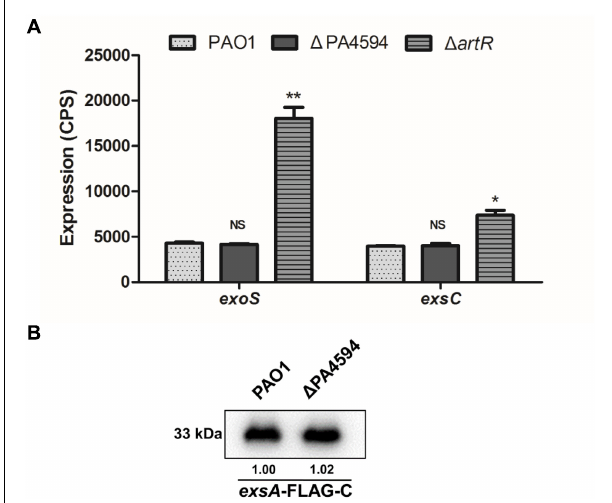
reporter plasmids pKD- exoS or pKD- exsC were cultured under T3SS inducing conditions. Promoter activities were measured after 6 h growth. Unlike artR ,